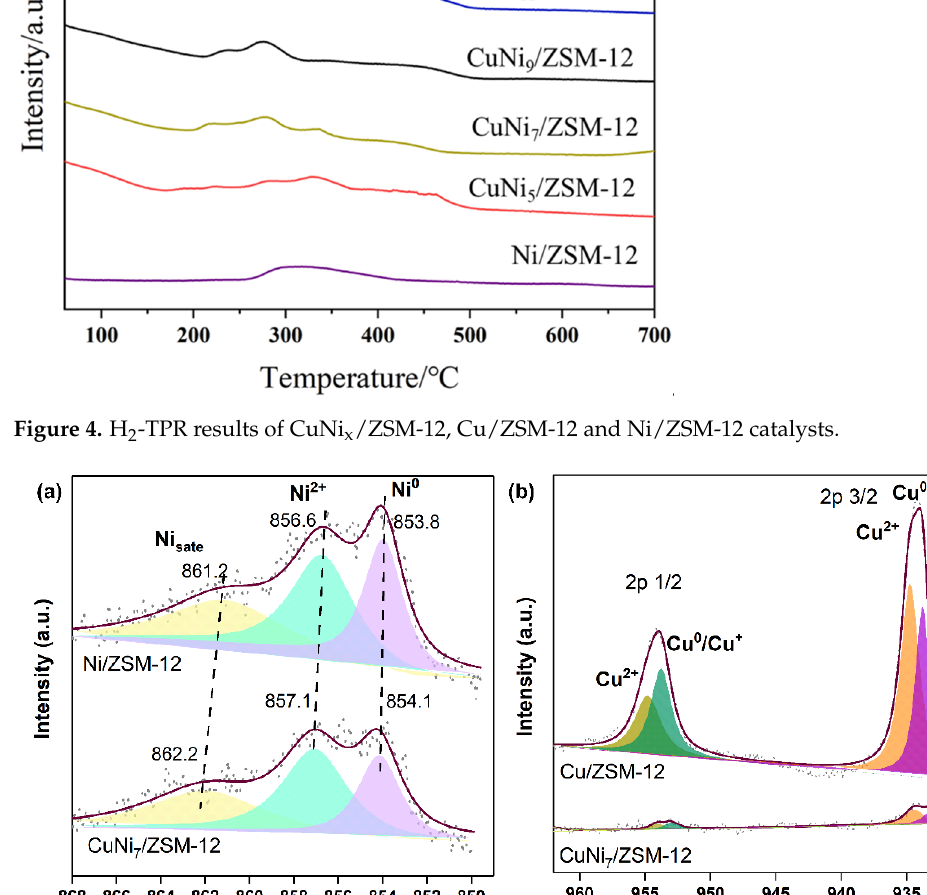
states of Cu are different.